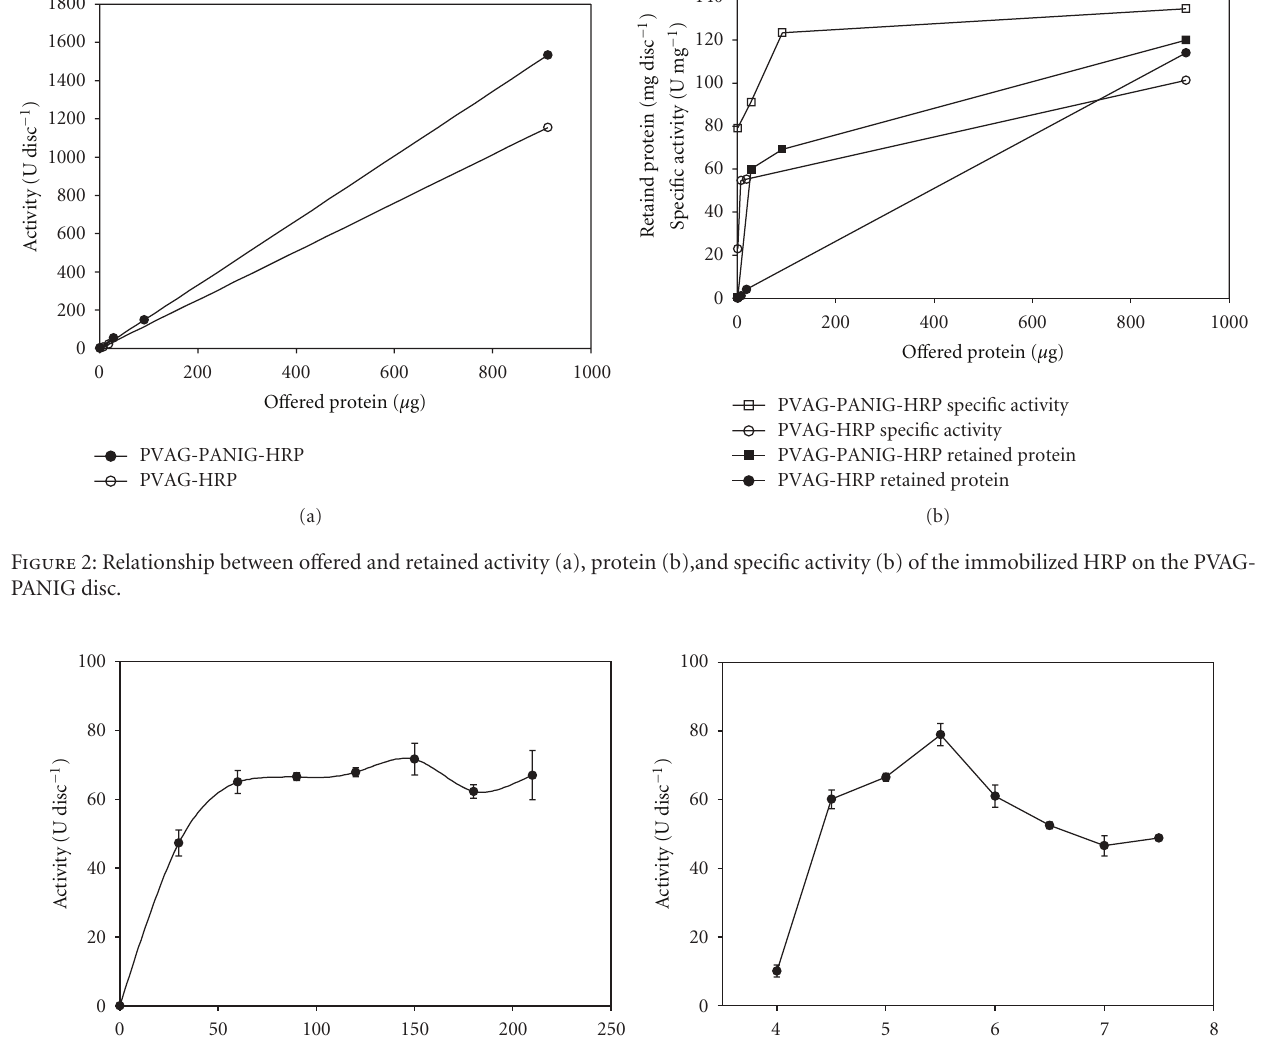
reported the PVAG-PANIG disc as a macroporous